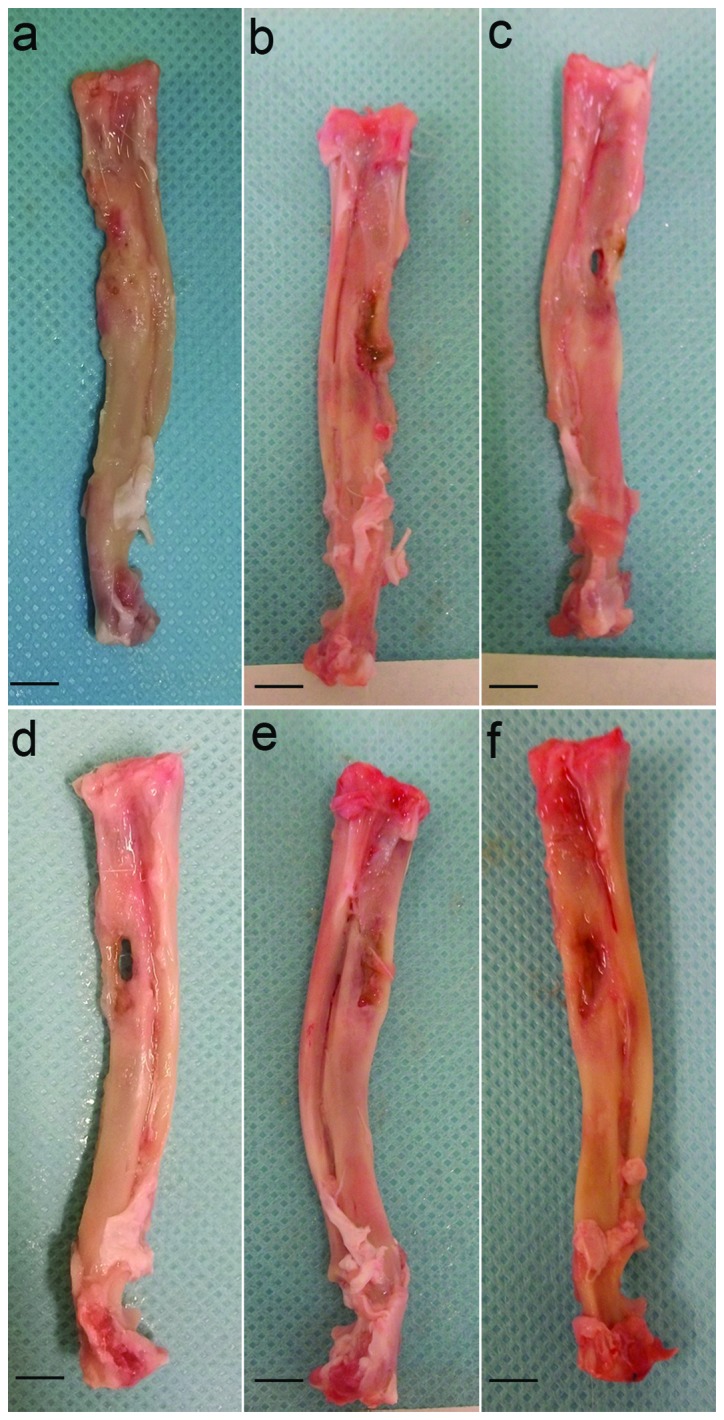
Gross observation of ulnar defects at (A–C) 4 and (D–F) 8 weeks following implantation. A and D, CS group; B and E, simvastatin-loaded CS group; C and F, rhBMP-2-loaded CS group; scale bar, 4 mm. CS, calcium sulphate; rhBMP-2, recombinant human bone morphogenetic protein 2.